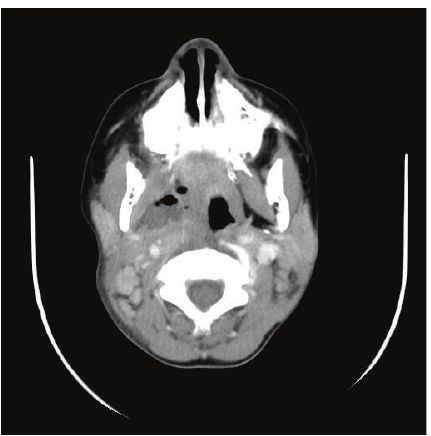
Figure 2: A CT scan with contrast showing compression of right internal jugular